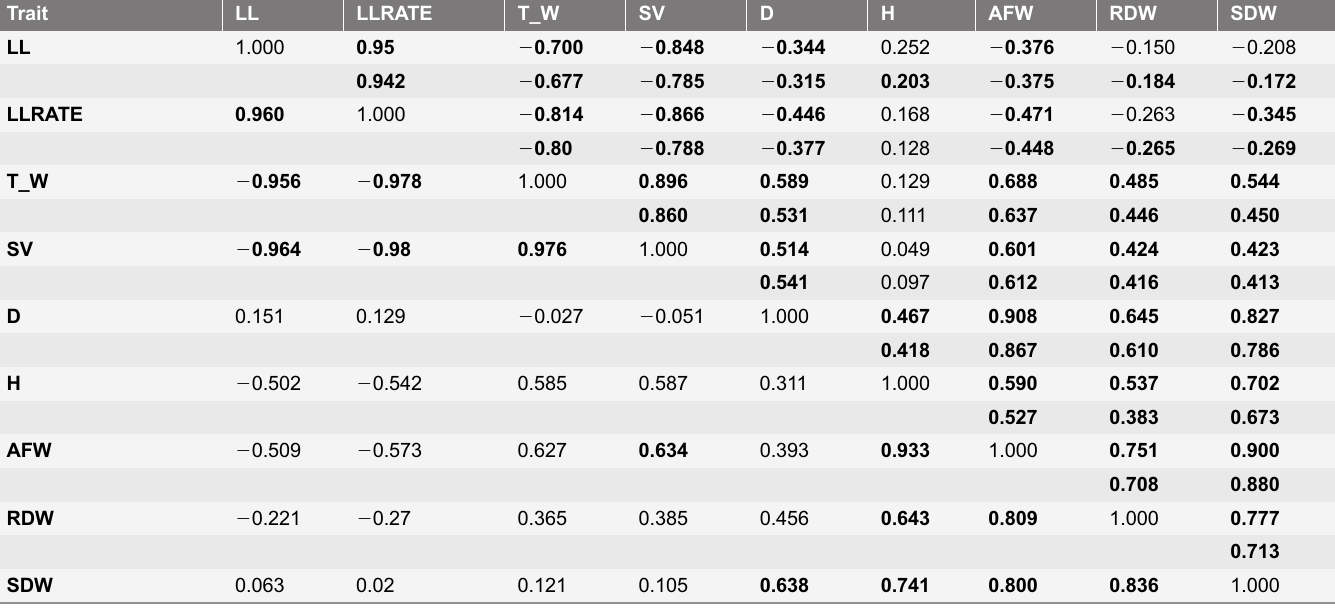
Lower triangle correlations between population BLUE values. Upper triangle: for each trait, first row correlations between family BLUP values (additive genetic correlation), second row correlations between family plus clone BLUP values (total genetic correlation). Significant correlations (p , 0.05) in bold letter. Trait abbreviations in Table